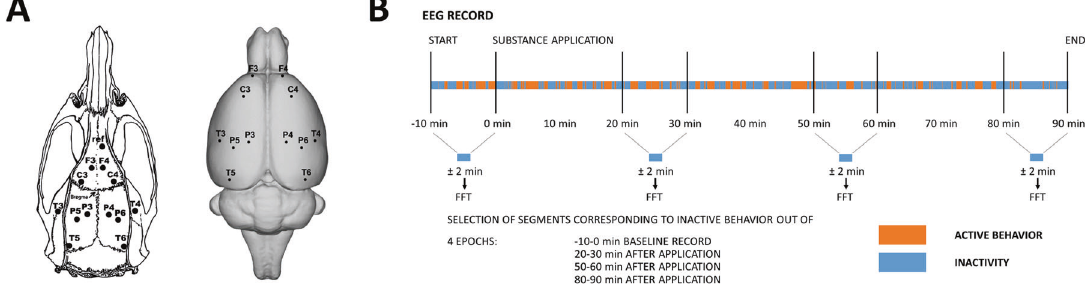
Fig. 1 Experimental design. A Layout and labeling of the electrodes on the rat ’ s skull (left) and brain (right). B Schematic drawing illustrating the time course of the experiment and selection of signals for further analysis. Four time epochs were selected. Out of each 10-min epoch, only artifact-free EEG signals corresponding to behavioral inactivity segments (in blue) altogether lasting ±2 min were selected and further subjected to Fast Fourier Transform and subsequent